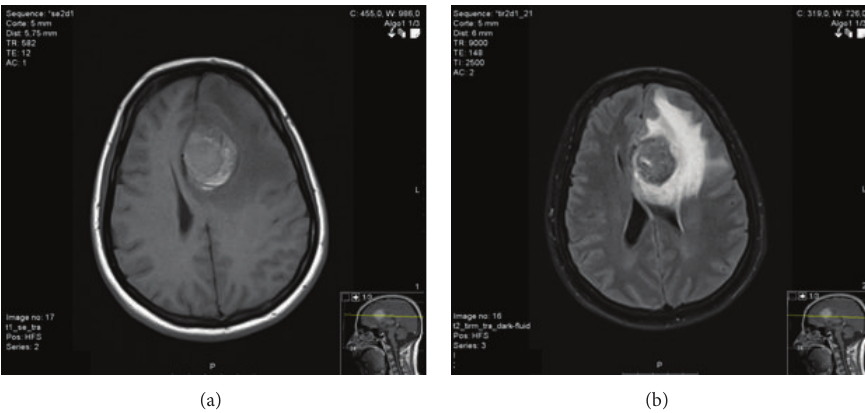
Figure 2: Cerebral magnetic resonance imaging revealing a large expansive lesion in the left frontal region. The lesion is heterogeneous on T1 with iso- and hyperintense areas, hypointense on FLAIR, and heterogeneous and markedly hypointense on